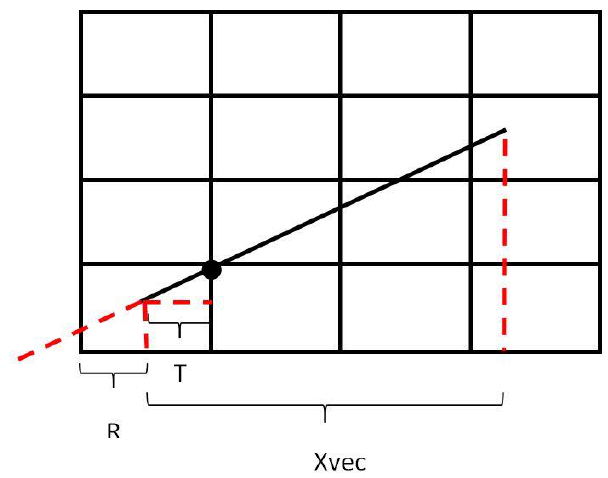
Figure 4. Two dimensional demonstration of the fast voxel traversal algorithm for ray tracing. (The